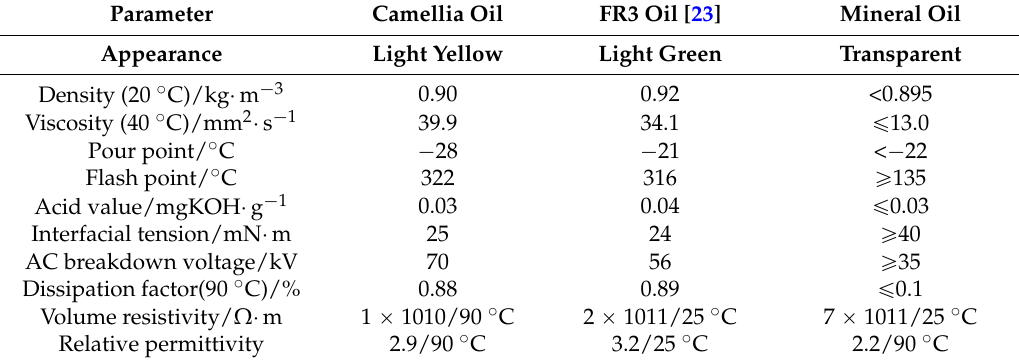
Table 1. Basic physical, chemical, and electrical properties of the three types of insulation